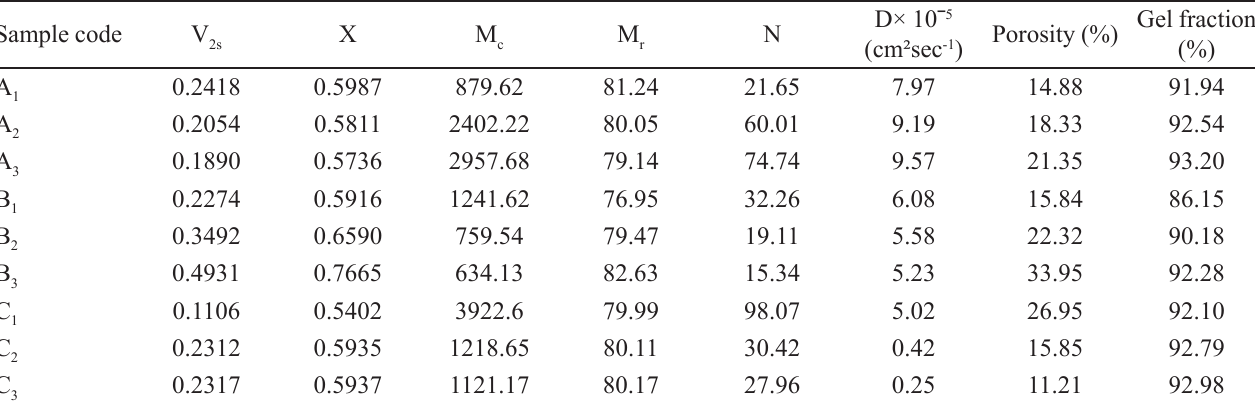
: volume fraction of polymer at equilibrium swelling in USP phosphate buffer solution, χ: solvent interaction parameter, M V 2s average value of molecular weight between crosslinks, M crosslinks, D : diffusion coefficient at pH